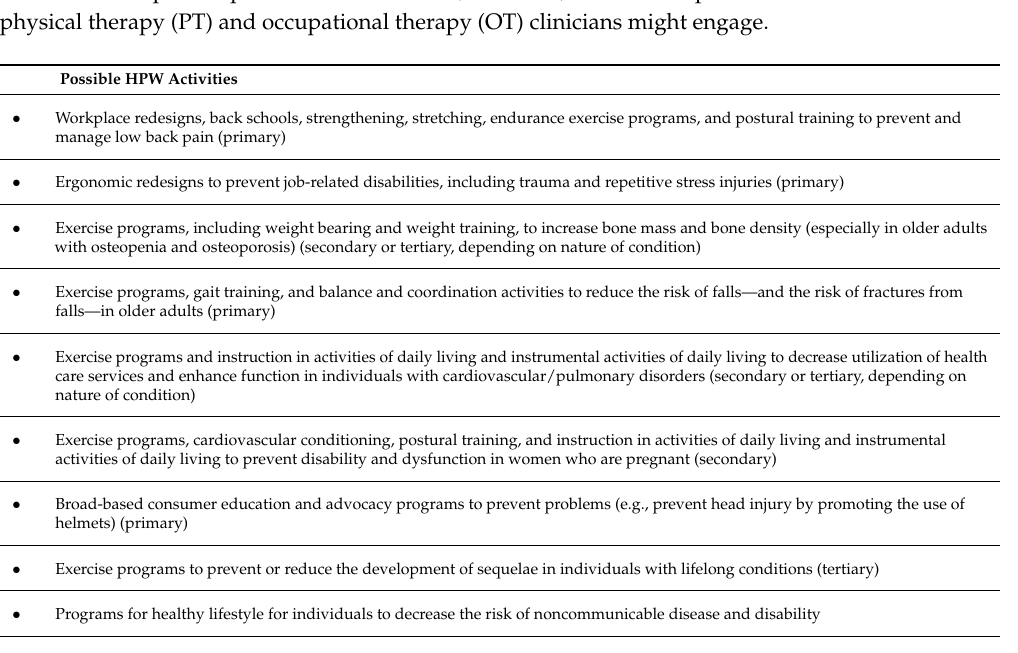
Table 1. Examples of prevention and health, wellness, and fitness promotion activities in which physical therapy (PT) and occupational therapy (OT) clinicians might engage.